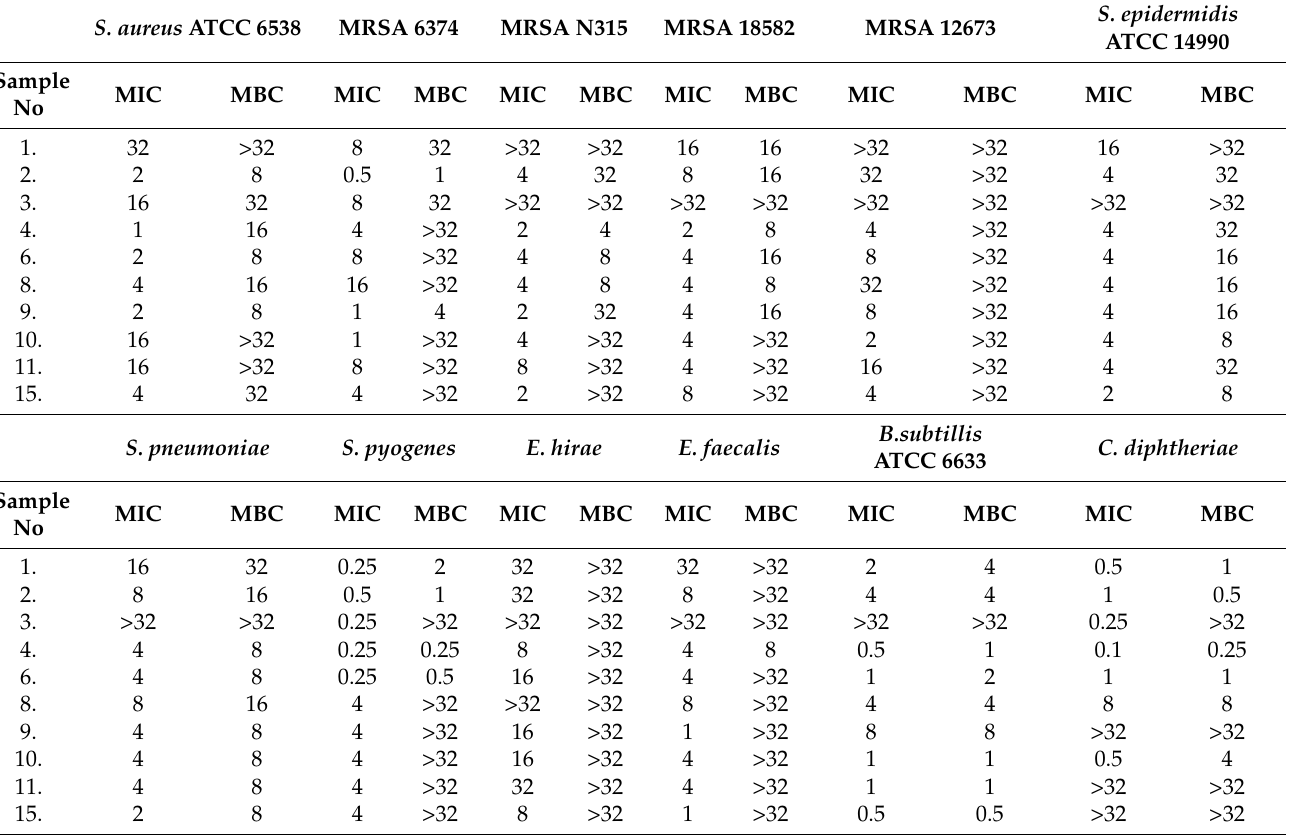
Table 5. Antibacterial activity of the aqueous extracts from W. somnifera (mg/mL) expressed as MIC and